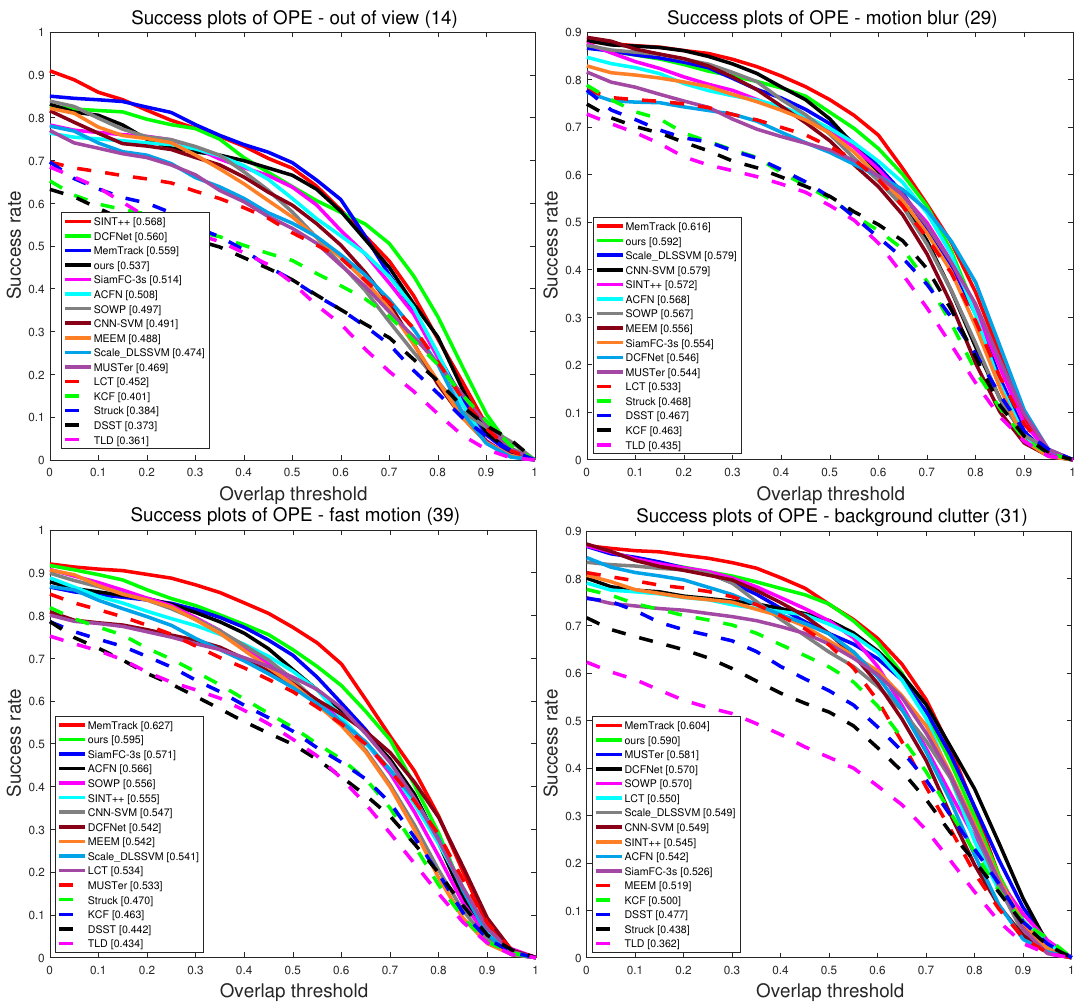
Figure 6. The evaluation results of precision rate (PR) and success rate (SR) on eight